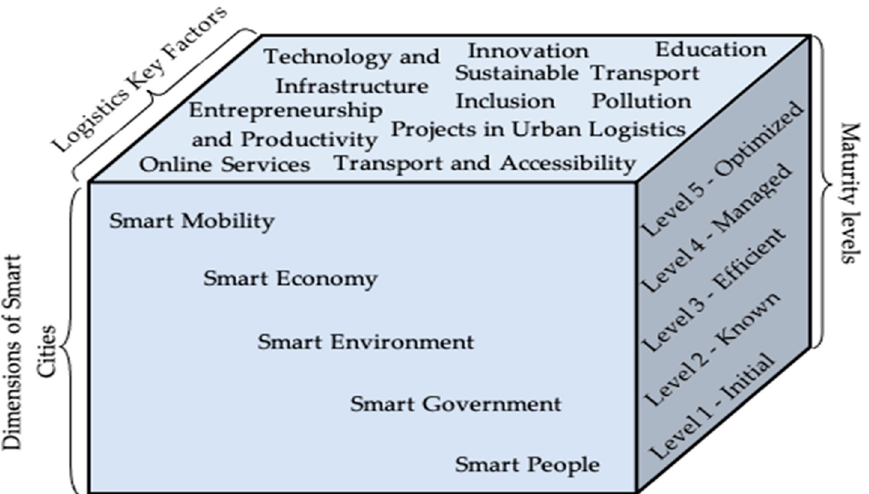
Figure 3. Framework for integrating logistical factors, smart city, and maturity levels.